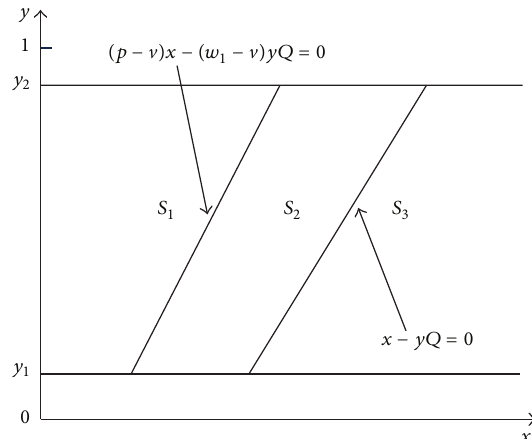
Figure 1: A graphical presentation of the demand and the yield rate under a WP